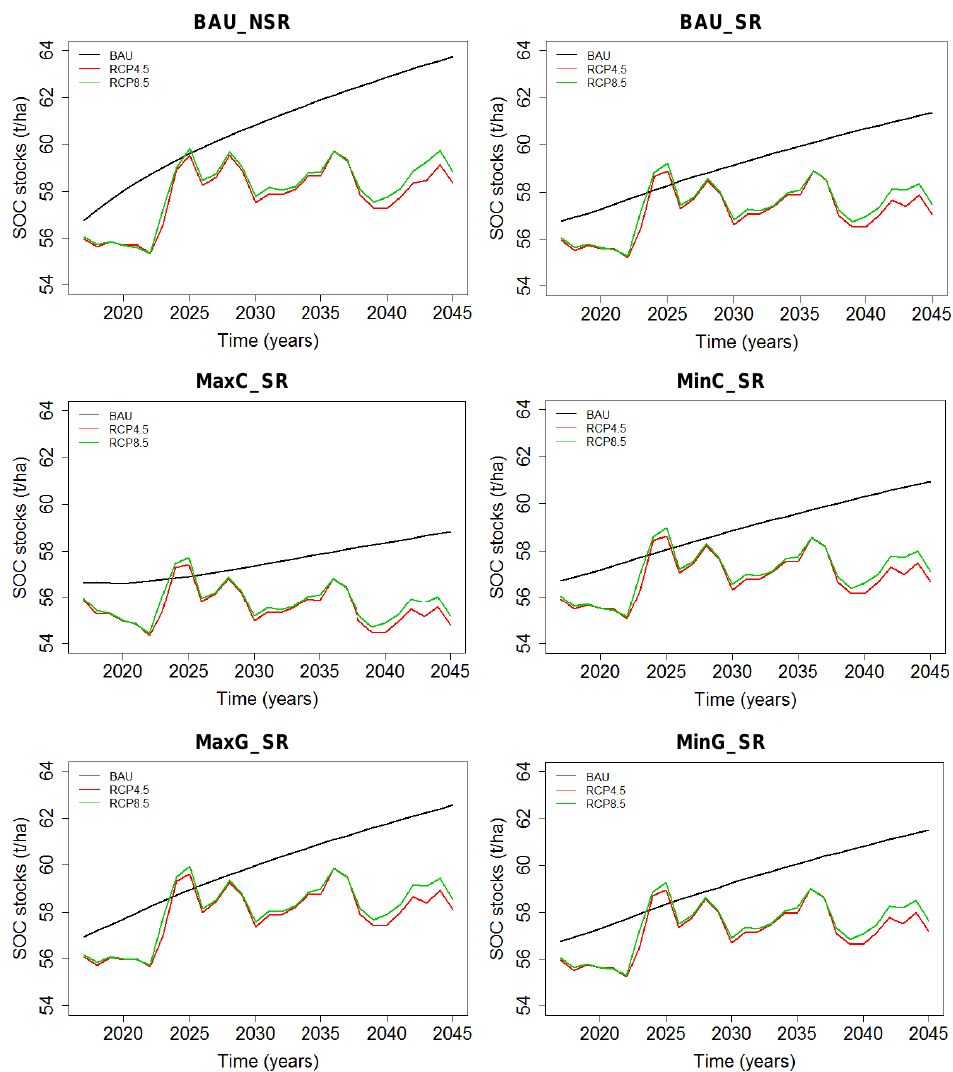
1 Figure 9. The simulated effect of climate change (BAU, RCP4.5 and RCP8.5) on SOC dynamics under different landscape scenarios (BAU_NSR, BAU_SR, MaxC_SR, MinC_SR, MaxG_SR and MinG_SR) in the 0–100 cm layer until ~2045. NSR: without soil redistribution. SR: with soil